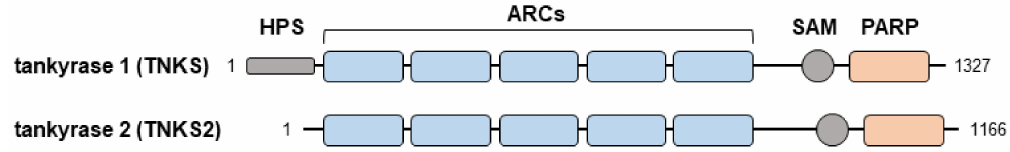
Figure 1. Structure of tankyrase 1 and 2. HPS, homopolymeric runs of histidine, proline, and serine; ARCs, ankyrin repeat clusters; SAM, sterile alpha module; PARP, catalytic